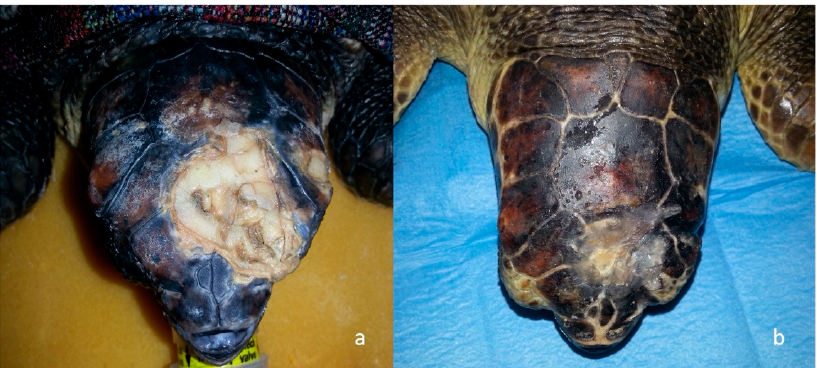
Figure 9. Example of a sea turtle with head trauma treated with surgical curettage and consequent application of 1 Primary wound Dressing ® . ( a ) Chronic trauma of left parietal and frontal bones with the evident presence of fibrotic tissue; ( b ) The same turtle after surgical curettage and 52 days application of One Vet ® . Table 1. Summary of the result of 29 sea turtles with head injuries: BCS, finding and lesion type, trauma and neurological scores, presence of buoyancy, use of tube-feeding to support nutrition, antibiotic therapy, and